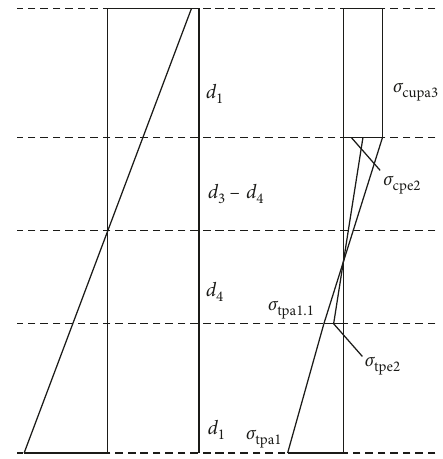
Figure 8: Stress-strain relationship of wood in CLTof three layers when compression failure.